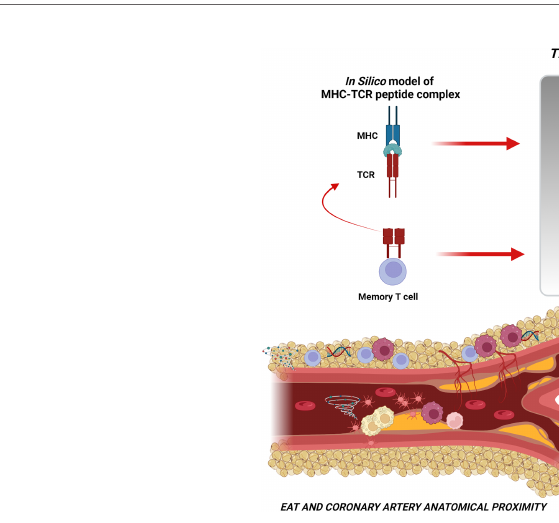
FIGURE 6 | Take-home fi gure. The fi gure shows the close relationship between EAT and coronary arteries and the intricate cellular and molecular network possibly implicated in the pathogenesis of ACS. The identi fi cation of a speci fi c T-cell clonal expansion in the EAT of NSTEMI patients at their fi rst clinical manifestation and the prediction of the putative sequence of the MHC – TCR – peptide complex (through in-silico modeling) indicate the existence in the EAT of an antigen-driven immune response likely involving microbiome-derived antigens as triggers for instability. These observations represent a signi fi cant step toward the perspective of engineered T-cell or epitope-based vaccine therapies. Created with